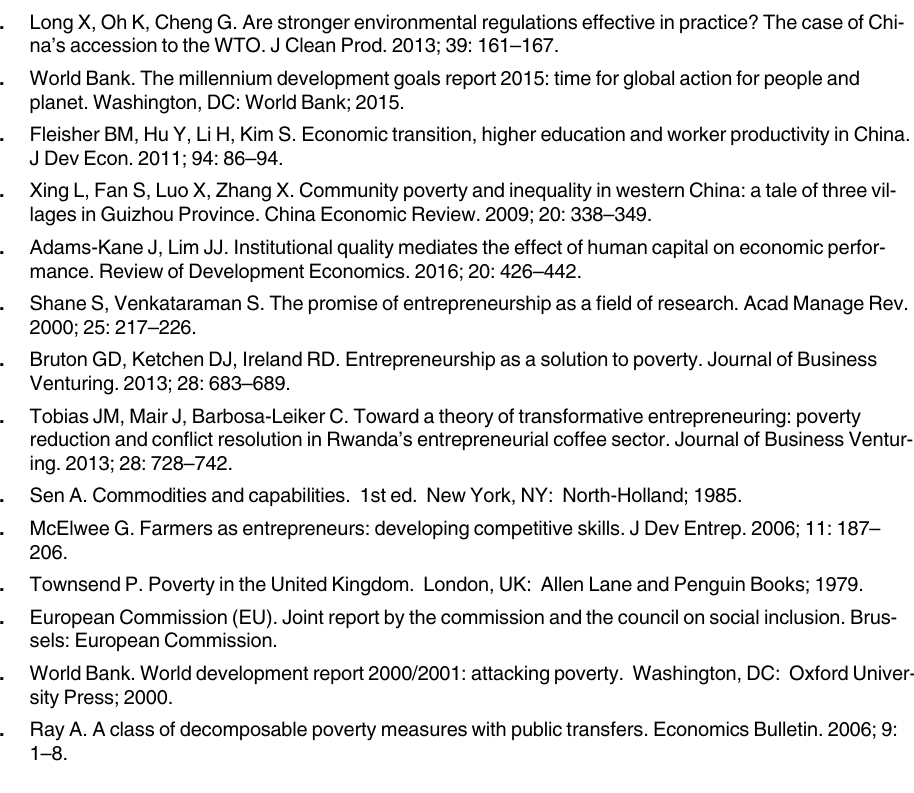
S3 Table. Correlation matrix